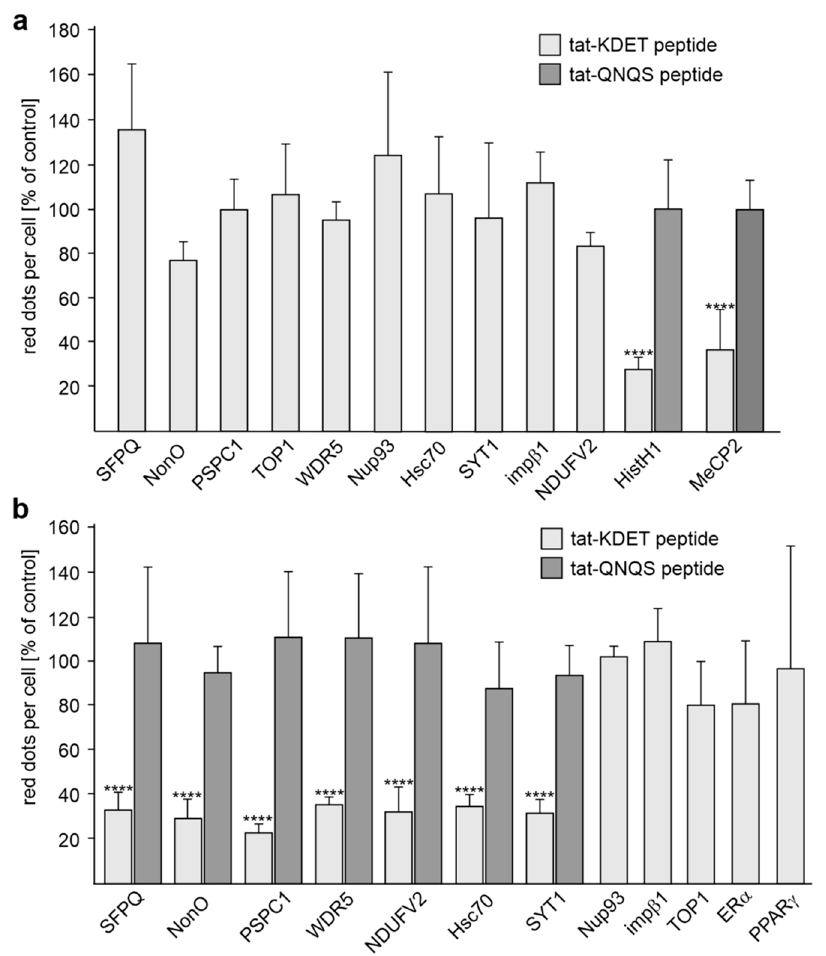
Figure 3. In cultured cortical neurons, L1 interacts with several binding partners via its KDET motif. Cultured cortical neurons were treated with vehicle, tat-KDET peptide, or tat-QNQS control peptide, followed by treatment without ( a ) and with ( b ) L1 antibody 557 and proximity ligation with a L1 antibody and an antibody against MeCP2, NDUFV2, SFPQ, NonO, PSPC1, WDR5, TOP1, HistH1, Nup93, Hsc70, SYT1, ER α , or PPAR γ . Mean values + SD from two independent experiments are shown for the average numbers of red dots per cell relative to control (values of treatment with vehicle set to 100%) (**** p < 0.001; one-way ANOVA with Bonferroni´s multiple comparison test).